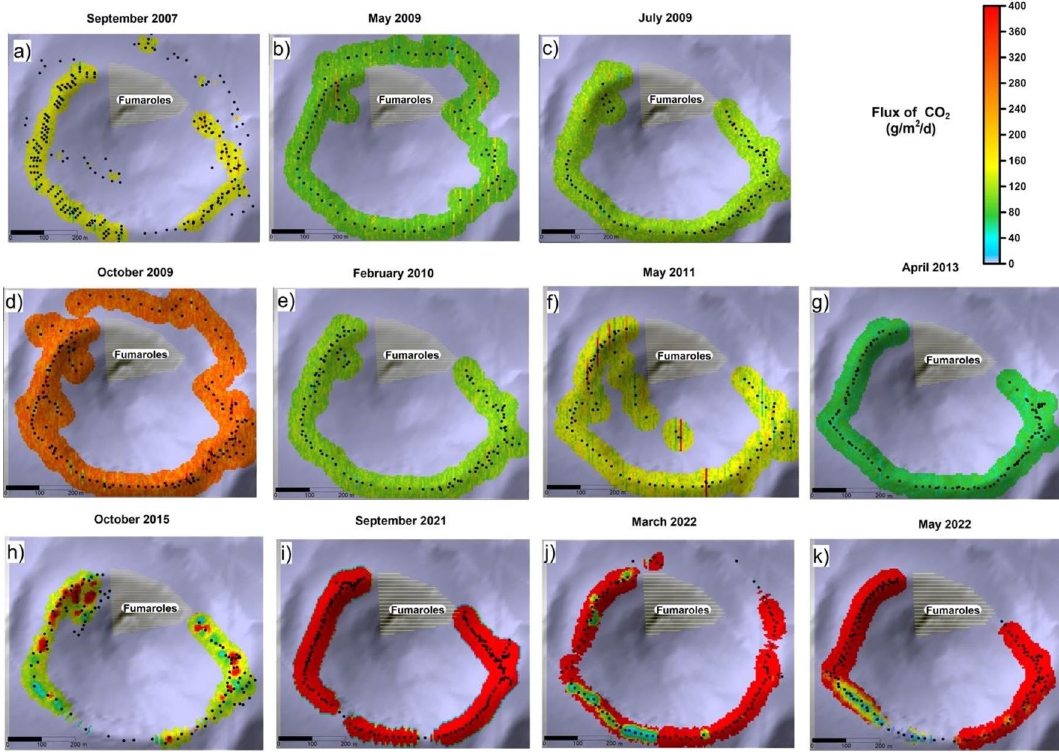
Figure 2. Soil CO 2 flux maps of summit area (in g m −2 d −1 ) obtained by the sGs 100 sequential Gaussian simulations from September 2007 to May 2022. The blanked area interested by intense fumarole emissions is also indicated. The maps were generated by Surfer Software Version 11.6.1159 Surface Mapping System (http:// www. golde nsoft ware.